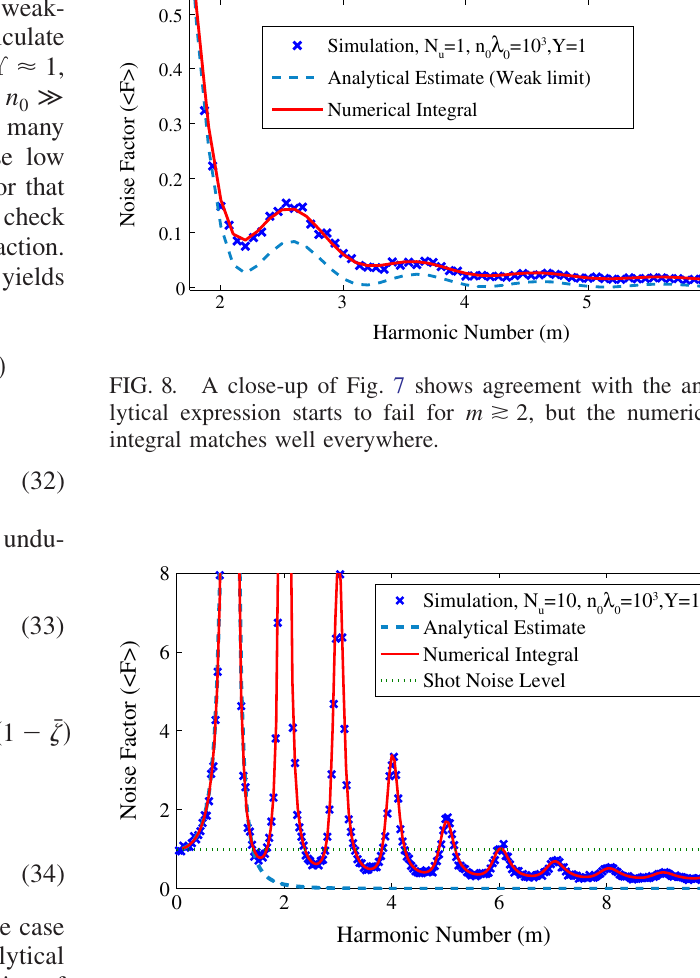
FIG. 9. A simulation example for ten undulator periods shows good agreement with the numerical